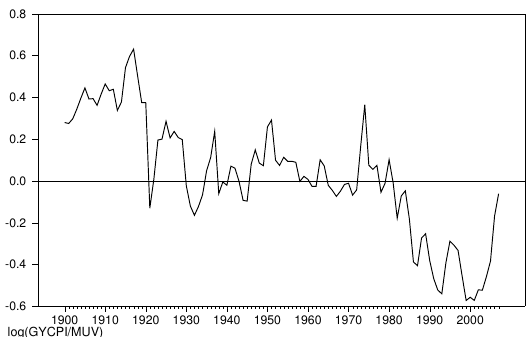
Figure 1. A plot of the logarithm of the annual real Grilli and Yang commodity price index from 1900 to